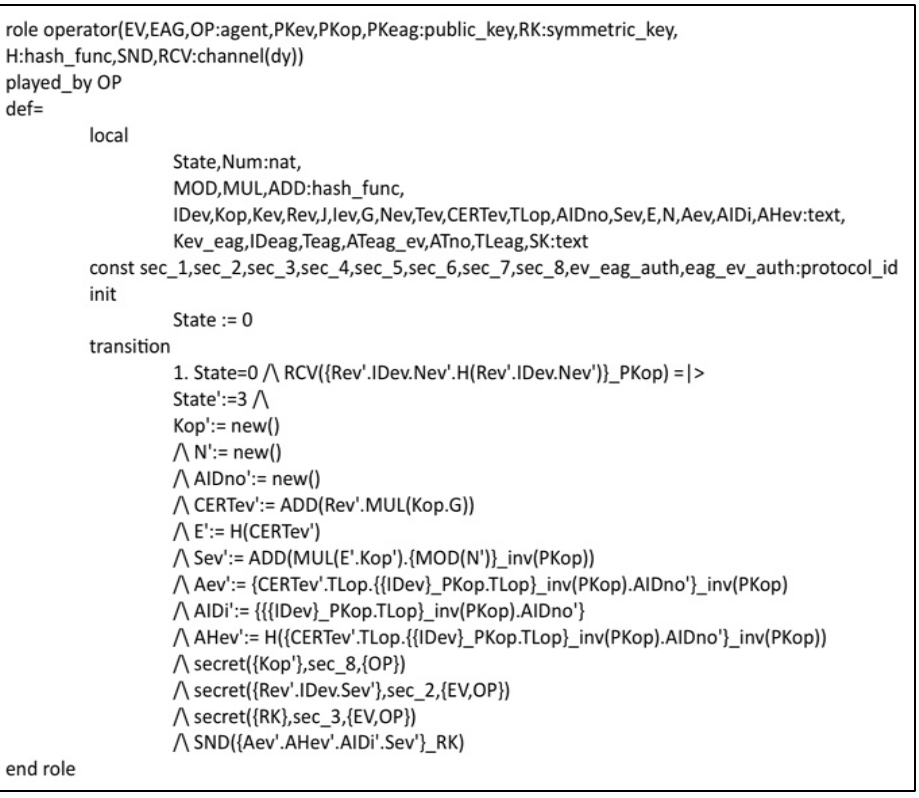
Figure 10. Mutual Authentication Specification of OP.